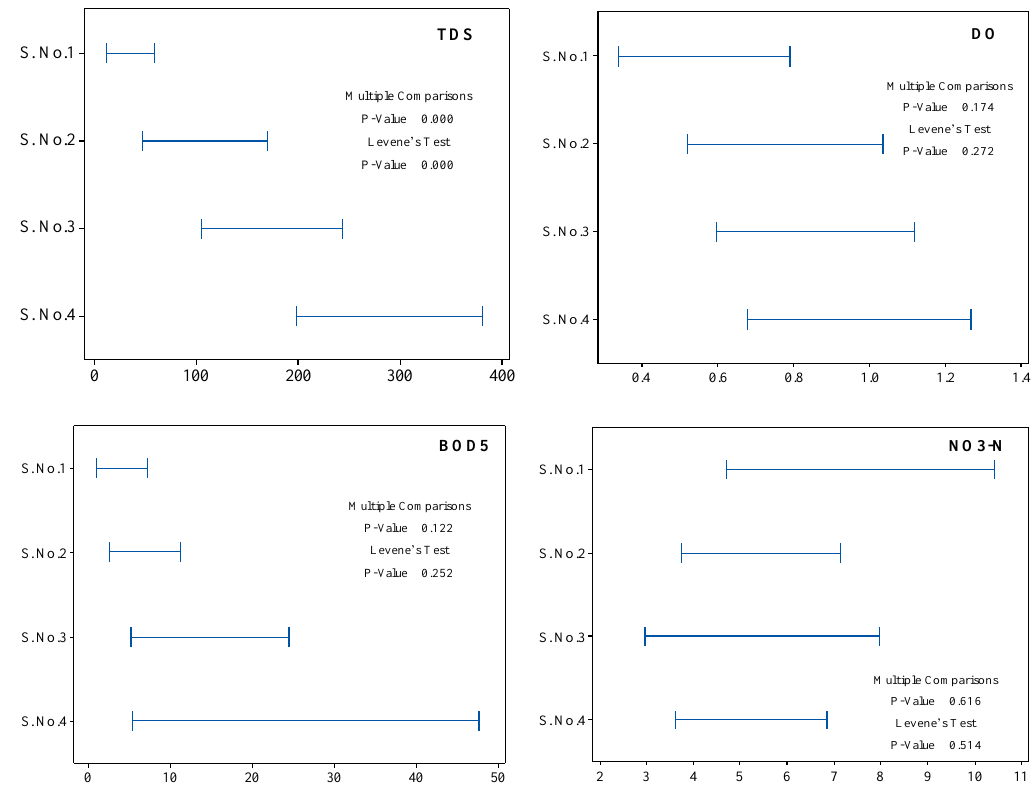
Figure 4. The variability of water quality parameters in terms of: TDS, DO, BOD 5 , and NO 3 -N at the four stations (S. No.1 to S. No.4) for the period from September 2013 to August 2014. Table 7. ANOVA results for the four stations.